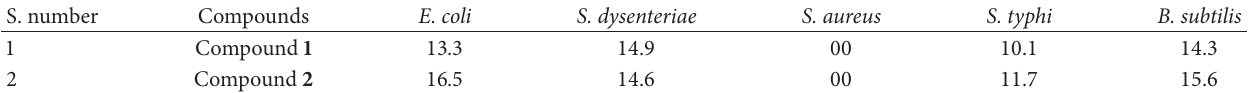
Table 4: Zone of inhibition (mm) of compounds 1 and 2 against different bacteria.